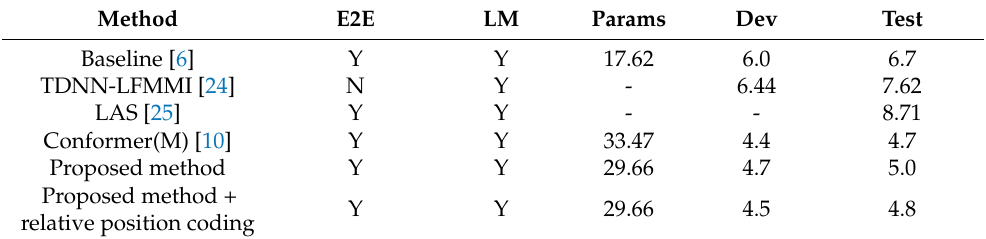
Table 1. Comparison of experiments for different models in multi-dimension on